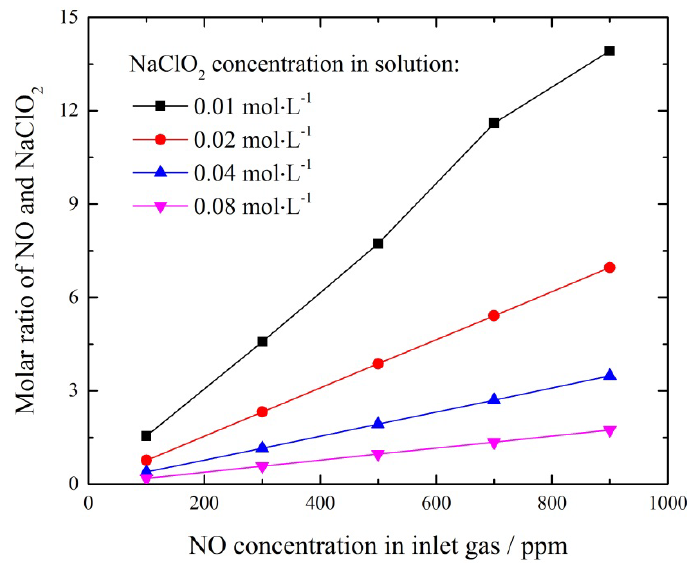
Figure 8. The change of the molar ratio of NO and NaClO 2 with inlet NO concentration.